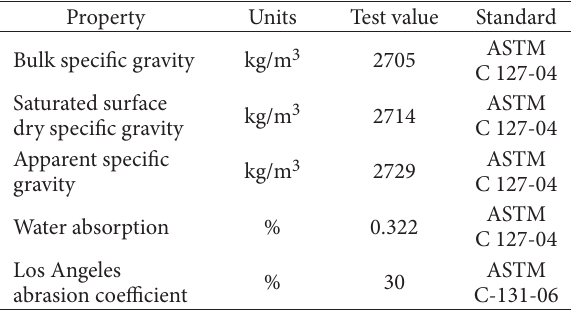
Table 2. Physical properties of coarse aggregates